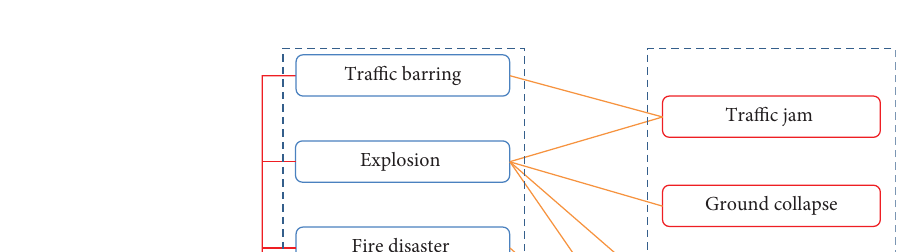
Figure 1: Classifcations of PE pipes [4, 5].